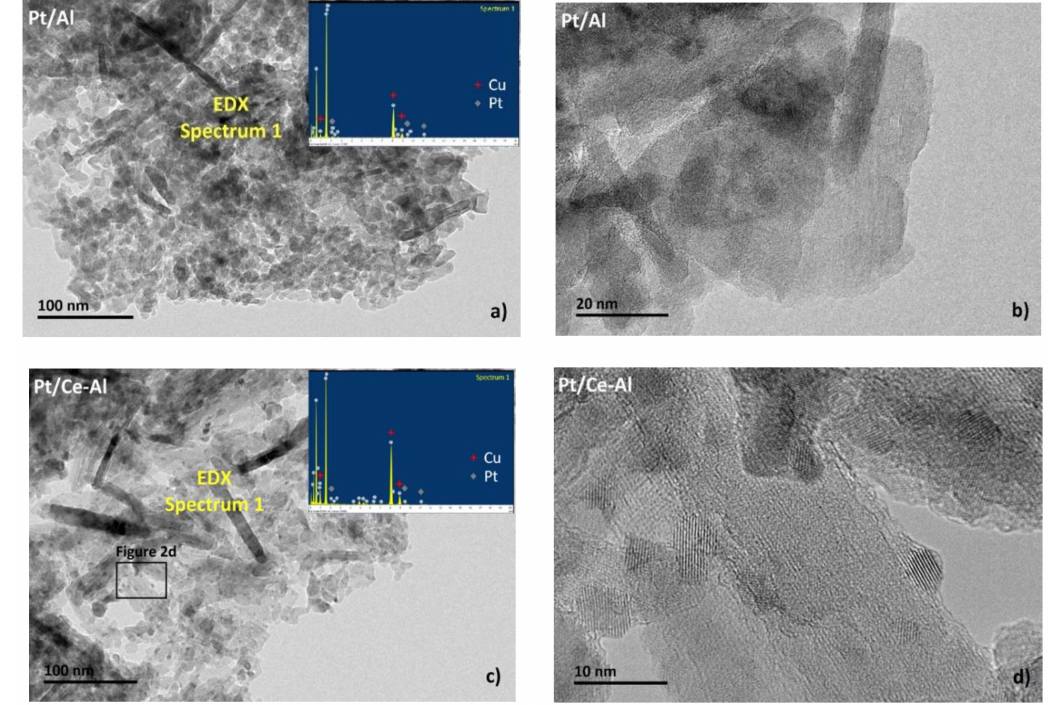
Figure 2. HR-TEM images of the Pt / Al 2 O 3 and Pt / CeO 2 -Al 2 O 3 catalysts: ( a ) EDX spectrum from the surface of Pt / Al 2 O 3 , ( b ) an example of a 20-nm scale image from the surface of Pt / Al 2 O 3 , ( c ) an EDX spectrum from the Pt / CeO 2 -Al 2 O 3 surface, and ( d ) an example of a 10-nm scale image showing the magnification from the inset in Figure 2c. (Cu peaks in the EDX spectrum originate from the used sample